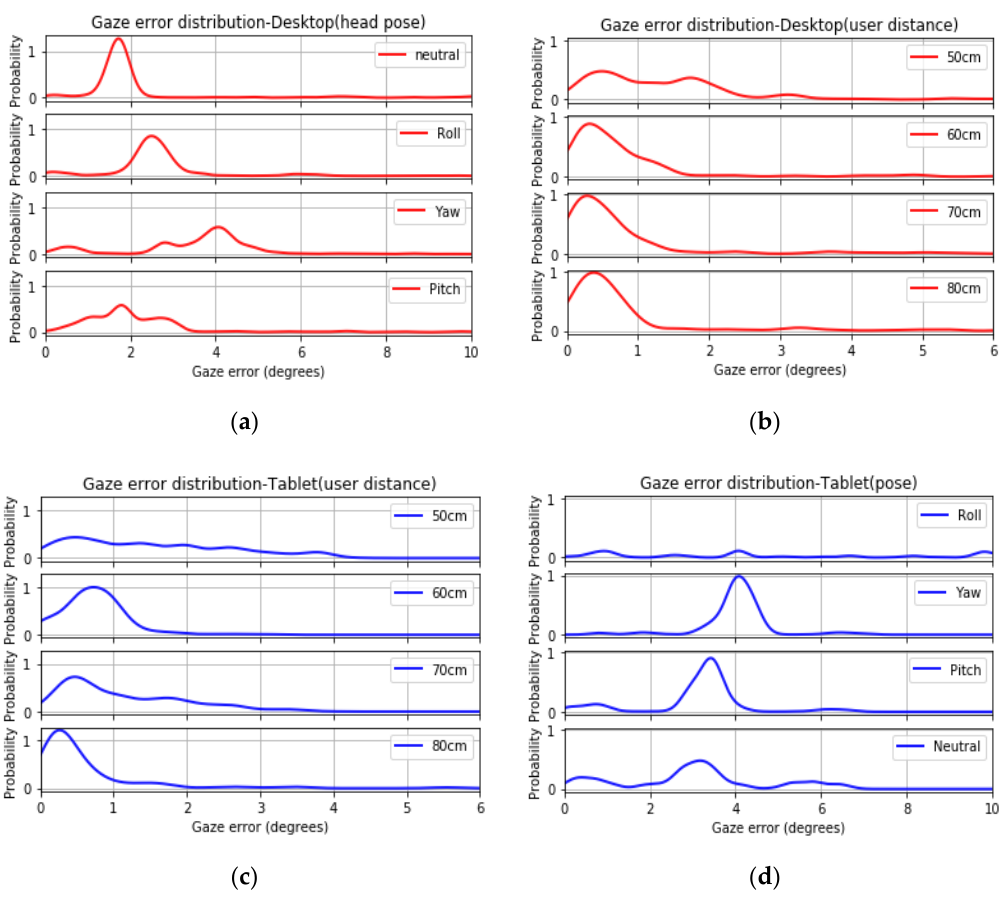
Figure 19. Gaze error distribution due to ( a ) user distance–desktop, ( b ) head pose–desktop, ( c ) user distance–tablet, and ( d ) platform pose–tablet.